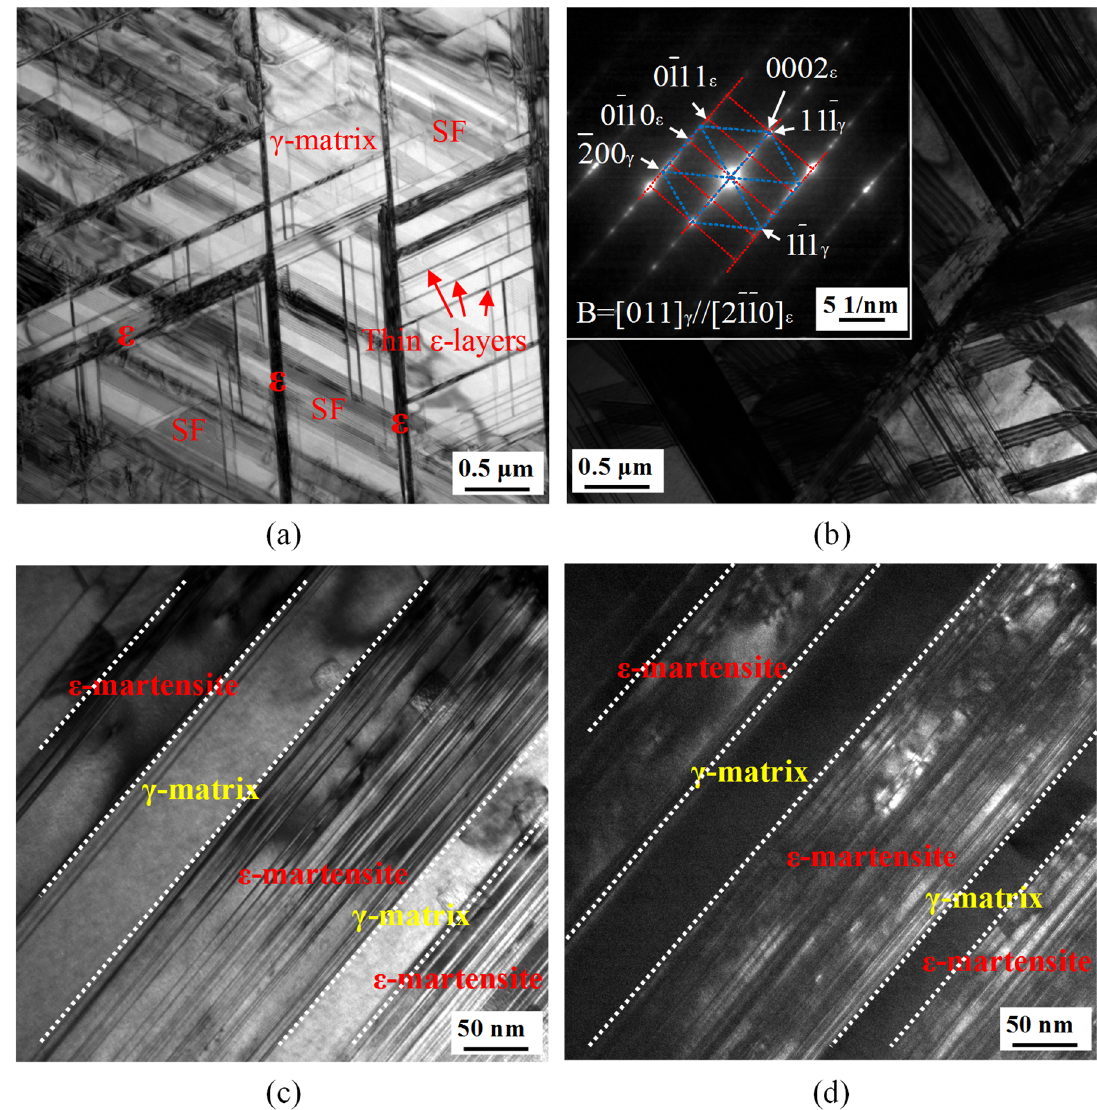
Figure 4. TEM micrographs of (a), (c) and (d) the Fe-19Mn alloy and (b) the Fe-19Mn-8Cr-1Co-0.2Si alloy after solution treatment: (a) the bright-field image of Fe-19Mn, showing γ-austenite matrix, ε-martensite, thin ε-martensite layers and stacking faults; (b) the bright-field image with inset of SAEDP; (c) the brightfield image and (d) the corresponding dark-field image, showing the internal structure of ε-martensite laths. Seol and co-workers 17 reported that the α'-martensite the pre-existing thermal-induced ε-martensite plates within which many α'-martensite layers formed, as indicated by was generated from the pre-existing thermal-induced white arrows in Figs. 6d, 6f, 6j and 6l, whereas mark B ε-martensite observed by EBSD monitoring in suit and the deformation-induced ε-martensite formed by γ to ε phase represents the deformation-induced ε-martensite in which no transformation could not further transform, hence the α'-martensite formed in the plates and the phase boundaries of the ε-martensite are no longer straight. deformation-induced ε-martensite have no any contribution to The deformation-induced ε-martensite nucleates at the ε to α' phase transformation. In other words, transformations occurred during whole deformation process are pre-existing thermal-induced ε/γ interfaces and grows into the γ phase to γ to deformation-induced ε and thermal-induced ε to fill the gap between the thermal-induced ε-martensitic plates deformation-induced α'. In Figs. 6e and 6k, mark A represents end to encounter other thermal-induced ε/γ interfaces.